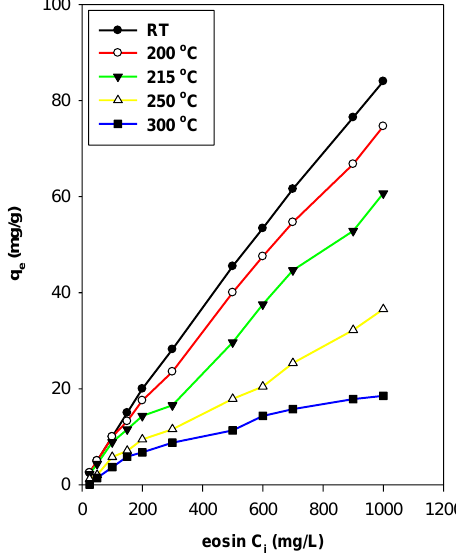
Figure 15. Removal capacity of C16BrPG-2.40 preheated at different temperatures.